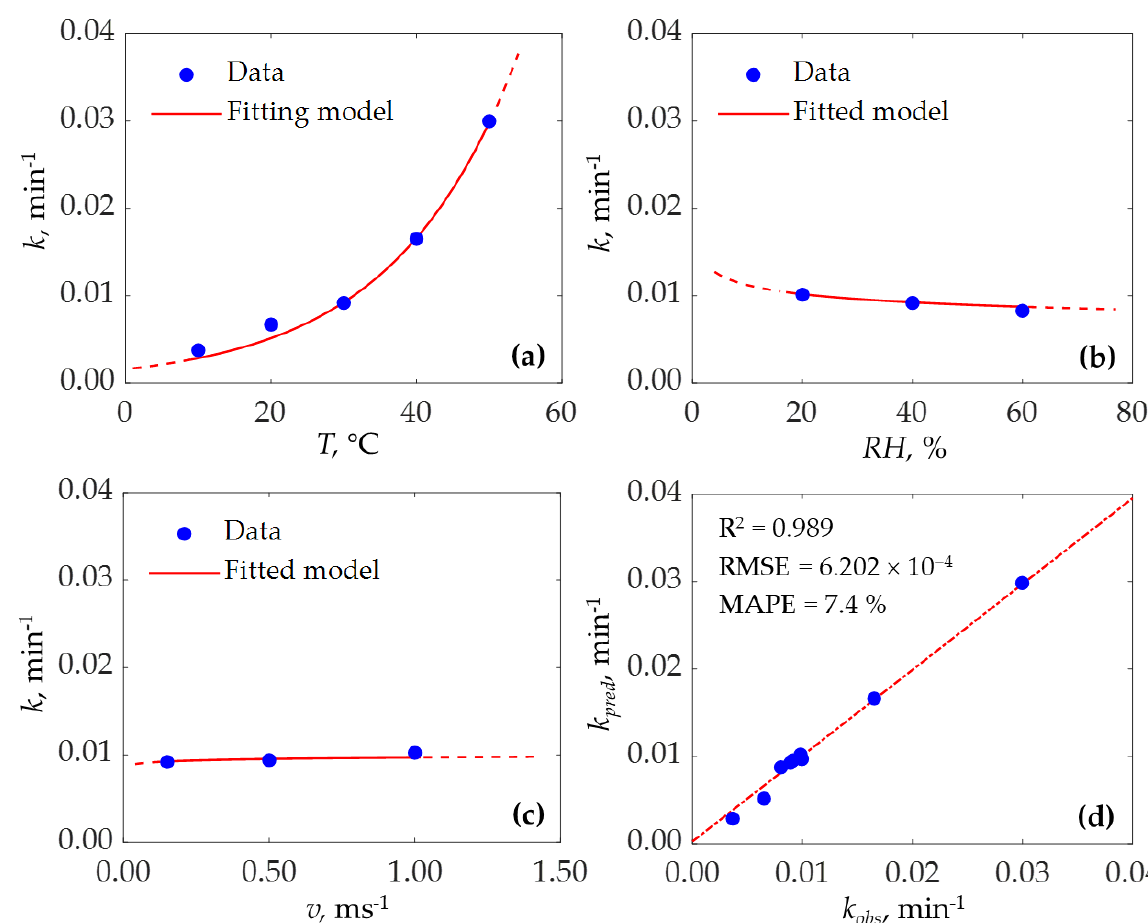
Figure 6. Drying constant k as affected by ( a ) the drying air temperature T , ( b ) relative humidity RH , and ( c ) airflow velocity v . Solid lines represent Page model fitting, dashed lines show extrapolation beyond the dataset used for fitting. ( d ) Predicted values of drying constant k pred vs. observed k obs .